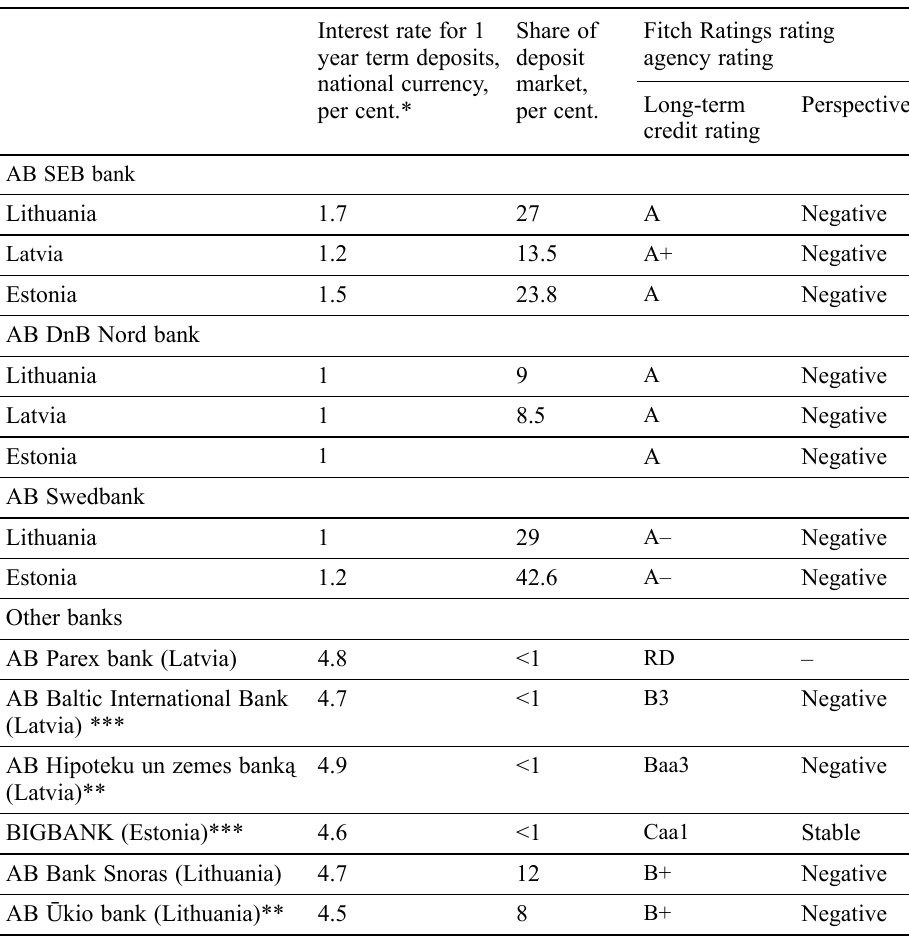
Table 3. The ratings and perspectives of the largest Baltic States banks in 2009 according to Fitch Ratings rating agency Interest rate for 1 Share of Fitch Ratings rating year term deposits, deposit national currency, market, per cent.* per cent.